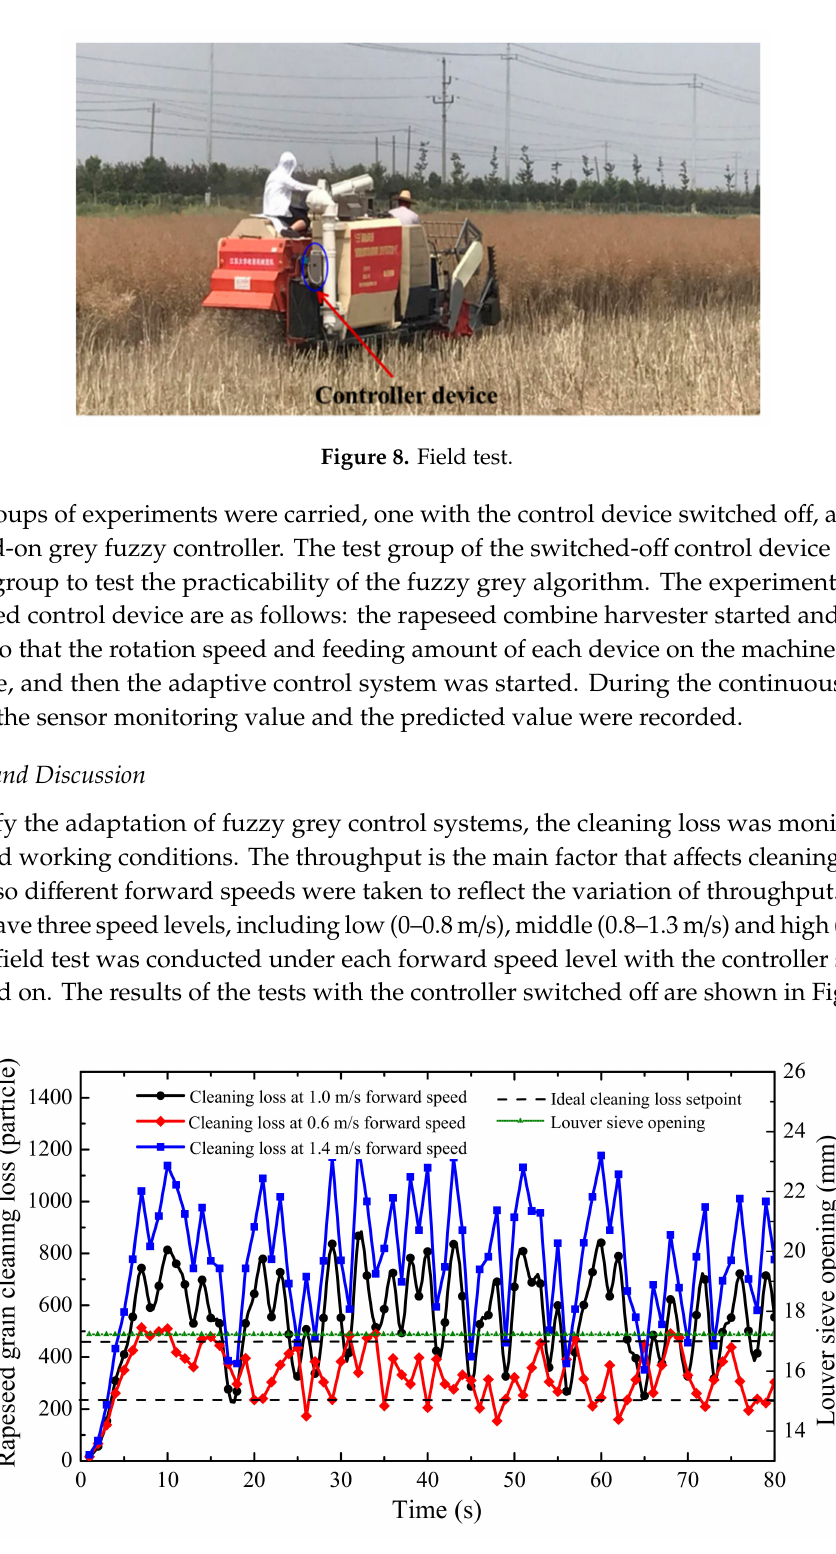
Figure 9. Field test with the controller switched o ff